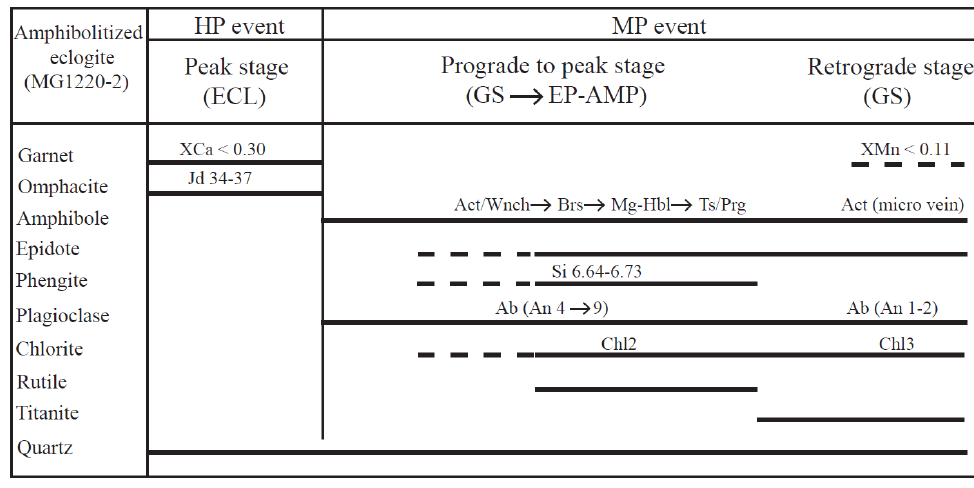
Figure 10. paragenesis of the amphibolitized eclogite.ECL, eclogite facies; EA-AMP, epidote-amphibolite facies; GS, greenschist facies.